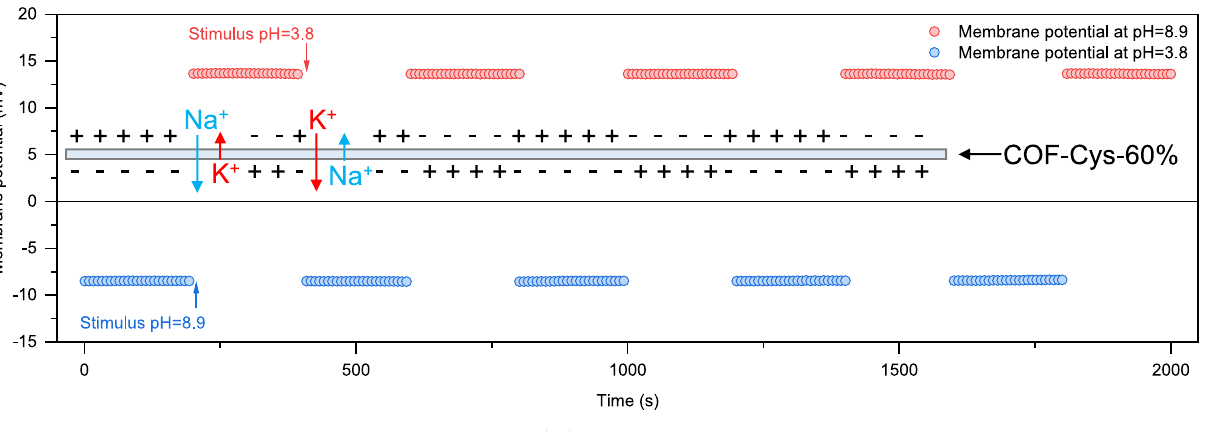
Fig. 5| Membranepotentialswitchesunderstimuli. a Adiagramshowing Na + /K + transport across the neuron membrane when stimulated to achieve signal trans- mission (created with BioRender.com). b Schematic illustration of membrane potential measurement (created with BioRender.com). A COF-Cys-60% membrane